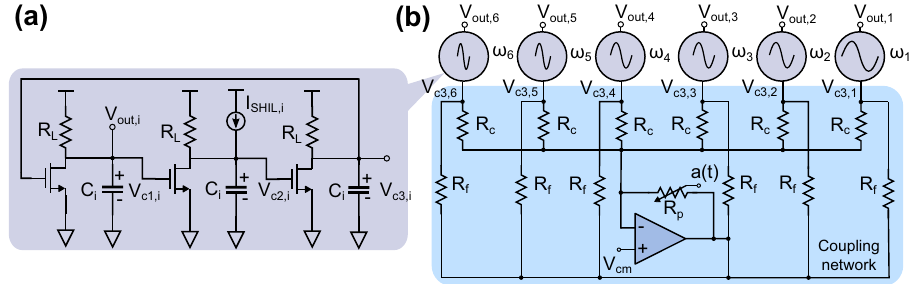
Figure 5. ( a ) A 3-stage SHIL RC ring oscillator and ( b ) a single hexagonal cell sharing a common coupling network consisting of six RC ring